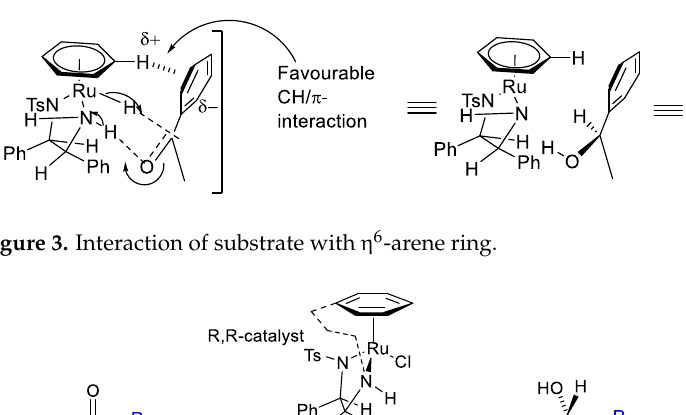
Figure 2. Mechanism of hydrogen transfer with Noyori – Ikariya catalysts.